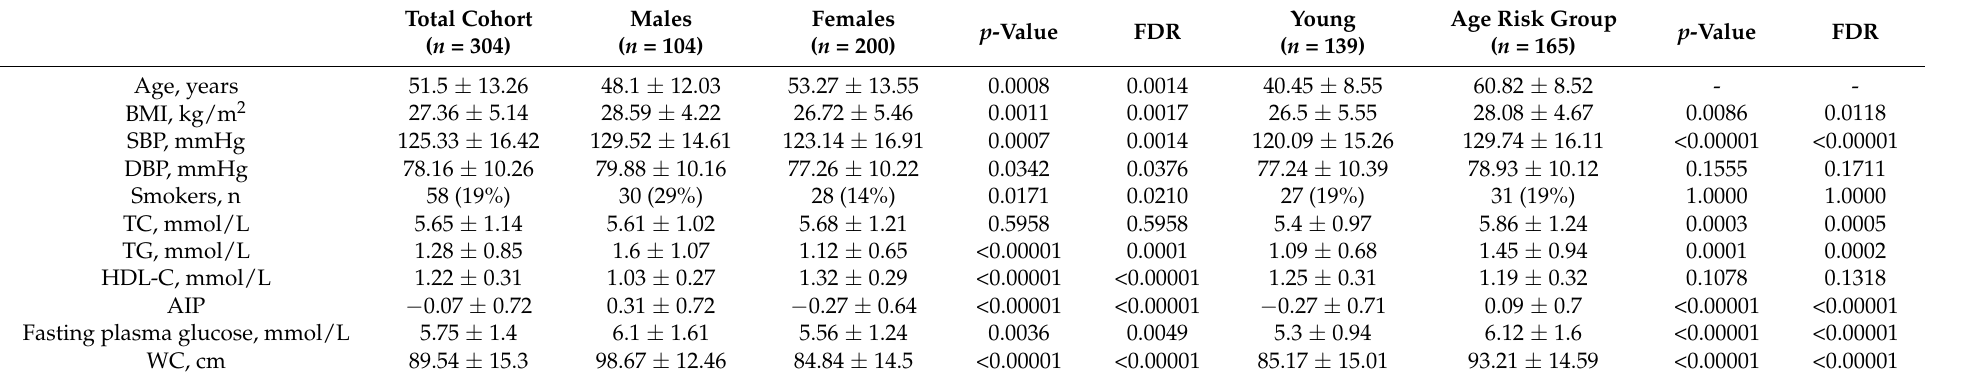
Table 1. Clinical characteristics of the studied participants.